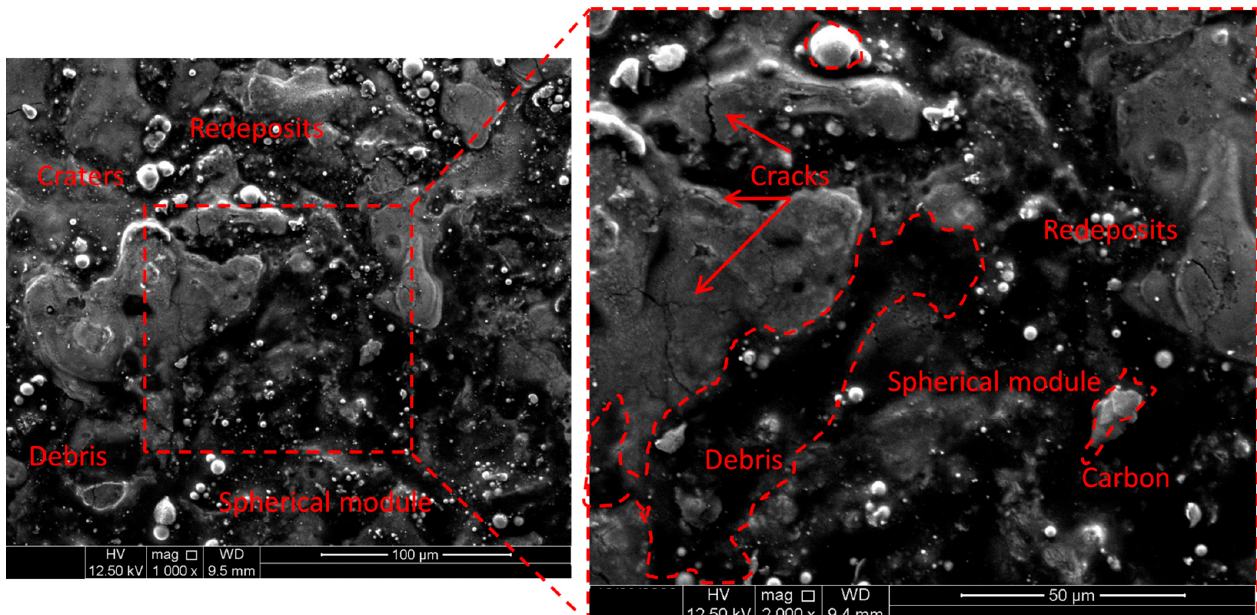
Figure 5. Surface morphology of kerosene-based dielectric at pulse ON:OFF time of 50:50 µSec and using graphite electrode.